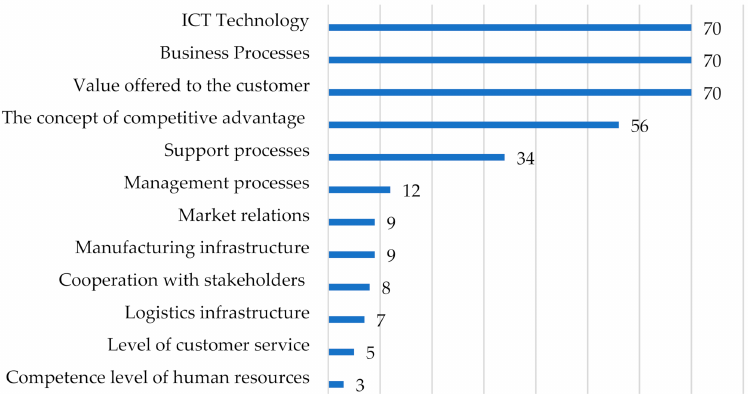
Figure 7. Elements of the business model that have changed as a result of implementing the pillars of Industry 4.0.